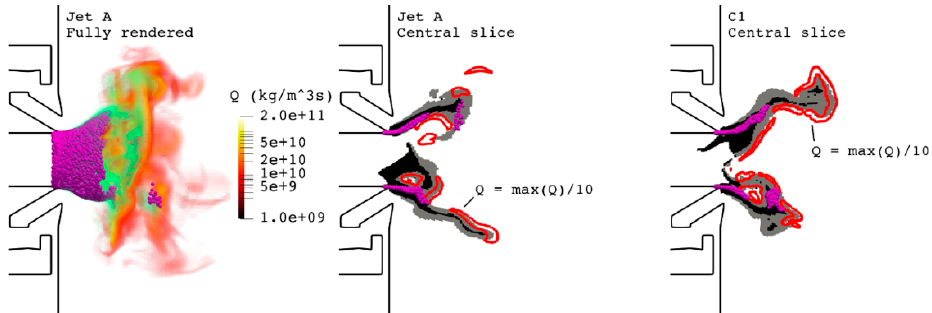
Figure 11. Snapshots of the simulated spray flame with walls included. Magenta: spray. Green: gaseous fuel. Left panel: fully rendered spray and flame for Jet A. The volume rendering of heat release ( 𝑄 ) is colored following a logarithmic scale. Center (Jet A) and right (C1) panels: central slice, with non-premixed regions in black and premixed regions in gray. Red: contour of 𝑄 = max(𝑄)/10 . To better understand the evolution of the fuel spray, the mean radial profiles of the diameter, 𝑑 (cid:3043) , and temperature, 𝑇 (cid:3043) , of the spray droplets are plotted in Figure 12 at three locations downstream of the burner. Experimental measurements [83] of the Sauter mean diameter (SMD) are included for comparison. At 𝑧 = 10 mm, where 𝑧 is the axial dis- tance from the burner, the fuel temperature has increased by 200 to 290 K from its injection temperature of 298 K. Recirculated combustion products in the ORZ heat the outermost droplets, giving them a high temperature. The CRZ has the same effect close to the cen- terline, though this is more obvious at 𝑧 = 15 mm and 𝑧 = 20 mm, where the CRZ has a higher concentration of hot combustion products than at 𝑧 = 10 mm. The saturation temperature at 10 bar is 616 K, forming the upper limit of the droplet temperature. The global temperature minima correspond to small local diameter maxima, which is logical, as low temperature leads to slow evaporation and, hence, relatively large droplets. Intui- tively, one would then expect the inner- and outermost droplets to have the smallest di- ameters, as they are subjected to the most heating. However, this does not appear to be the case for the outermost droplets, which are relatively large, despite being heated by the ORZ. This can be explained by noting that large droplets have higher inertia than small droplets [83], resulting in higher radial velocity in the swirling flow. Therefore, the drop- lets that reach far from the centerline tend to be large initially. The same phenomenon contributes to the small droplet sizes seen near the centerline. The simulated sprays agree with experimental diameter measurements. The largest error is seen close to the burner, at 𝑧 = 10 mm, where droplet diameters are underpre- dicted by 5 μ m. A likely major contributor to this error is the lack of an atomization model in the simulations. The liquid phase is assumed to be fully atomized already at the point of injection, whereas, in reality, the fuel forms a film at the pre-filmer lip, which is then atomized by the air flow. The error may be reduced by directly modeling the film behavior or by forgoing the pre-filmer lip entirely and injecting the Lagrangian phase downstream of it. The lack of atomization model is likely also the reason why few to no droplets are observed in the simulations at 𝑟 < 5 mm and 𝑟 > 22 mm: the motions of the droplets are not chaotic enough to fling droplets very far inward or outward.